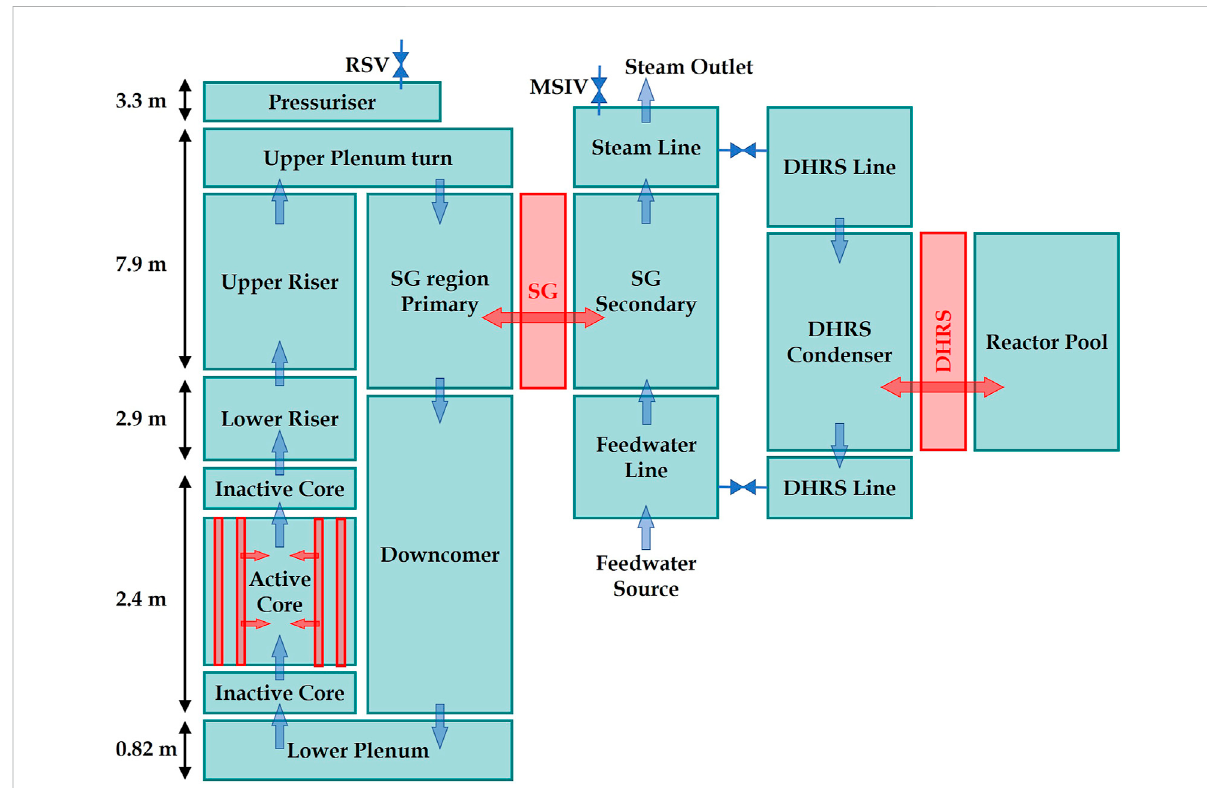
FIGURE 2 CESAR nodalization diagram of the NuScale system. Blue arrows show the expected coolant fl ow path under normal conditions; red arrows represent heat transfer from the fuel in theactive core and heat exchange through theSG and DHRS condenser tubes. Opening theDHRS actuation valves forms a fl ow circuit cooled by the reactor pool via natural